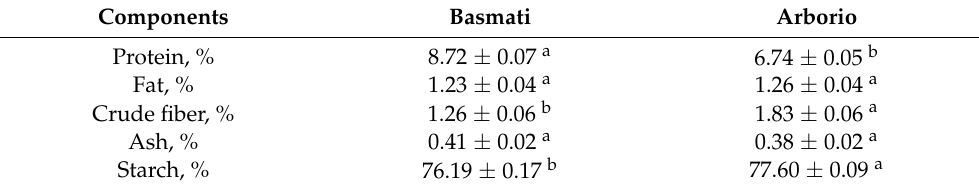
Table 1. Proximate compositions (% d.w.) of Basmati and Arborio commercial rice varieties. Components